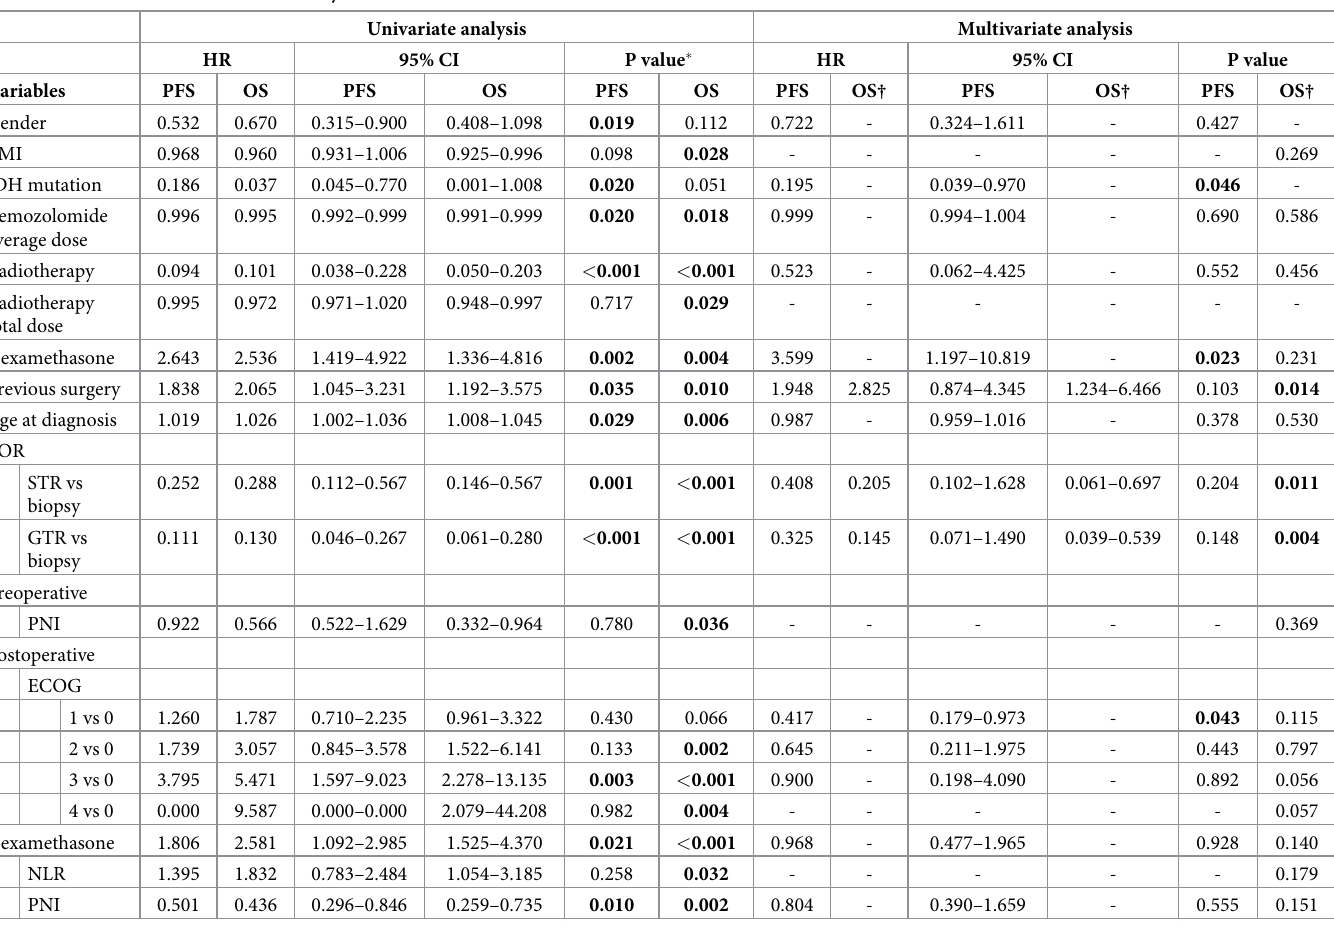
Table 3. Univariate and multivariate analyses for PFS and